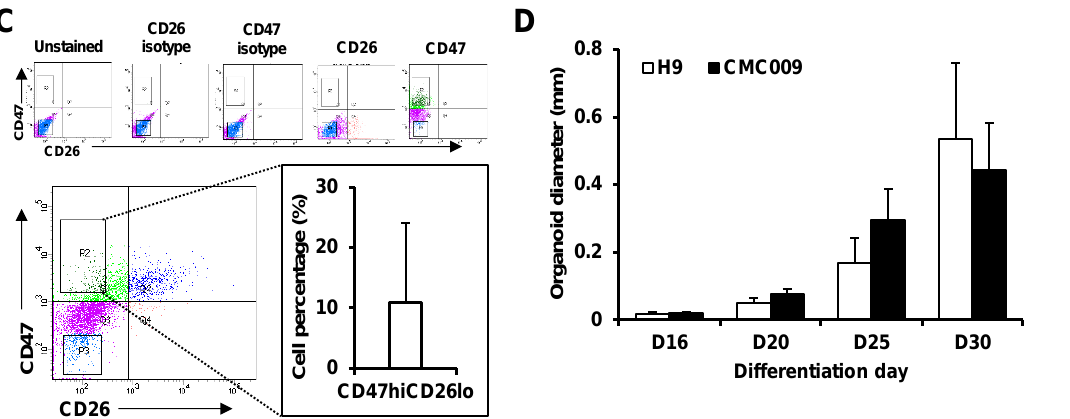
Figure 1. Generation of 3D lung organoids from hPSCs. ( A ) Schematic diagram of lung progenitor cell differentiation and 3D lung organoid generation from hPSCs. ( B ) The representative phase contrasts images of lung progenitor cells and lung organoids from hESCs and hIPSCs at differentiation days 0 to 30. Scale bar = 400 µ m. ( C ) The cell percentage of CD47hi CD26lo population. n = 5. ( D ) Measurement of organoid diameter at differentiation day 16 to 30. The error bar depicts standard deviation. n = 20.